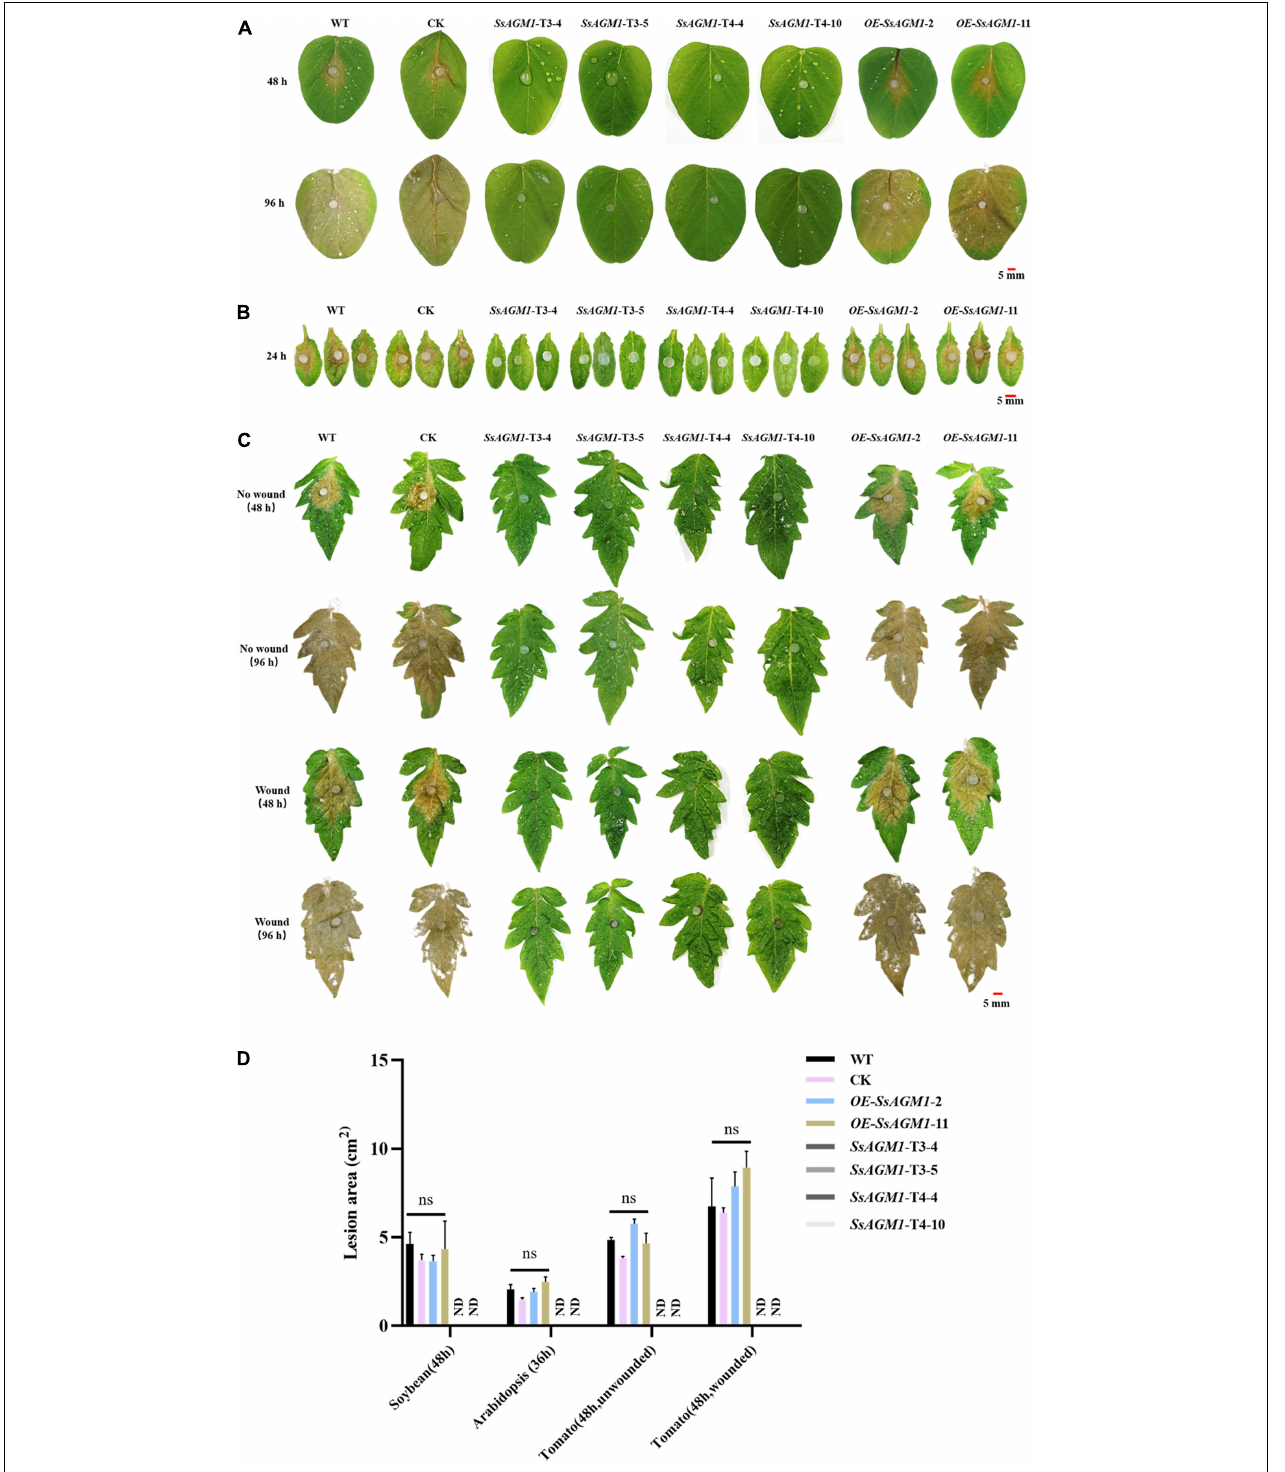
FIGURE 8 | SsAGM1 is essential for pathogenicity in Sclerotinia sclerotiorum. (A,B) Disease symptoms of soybean and Arabidopsis leaves inoculated with wild-type strain, control strain, gene-silenced transformants, and overexpression transformants. (C) Wild-type strain, control strain, gene-silenced transformants, and overexpression transformants were inoculated on intact and wounded tomato leaves. (D) Quantitation of lesion sizes in (A–C) . The lesion area was calculated by ImageJ. One-way ANOVA; n = 3; ns, represents no significant difference from WT at p < 0.05. ND, not detected. Data represent means ± SD. WT, Wild-type strain; CK, the control